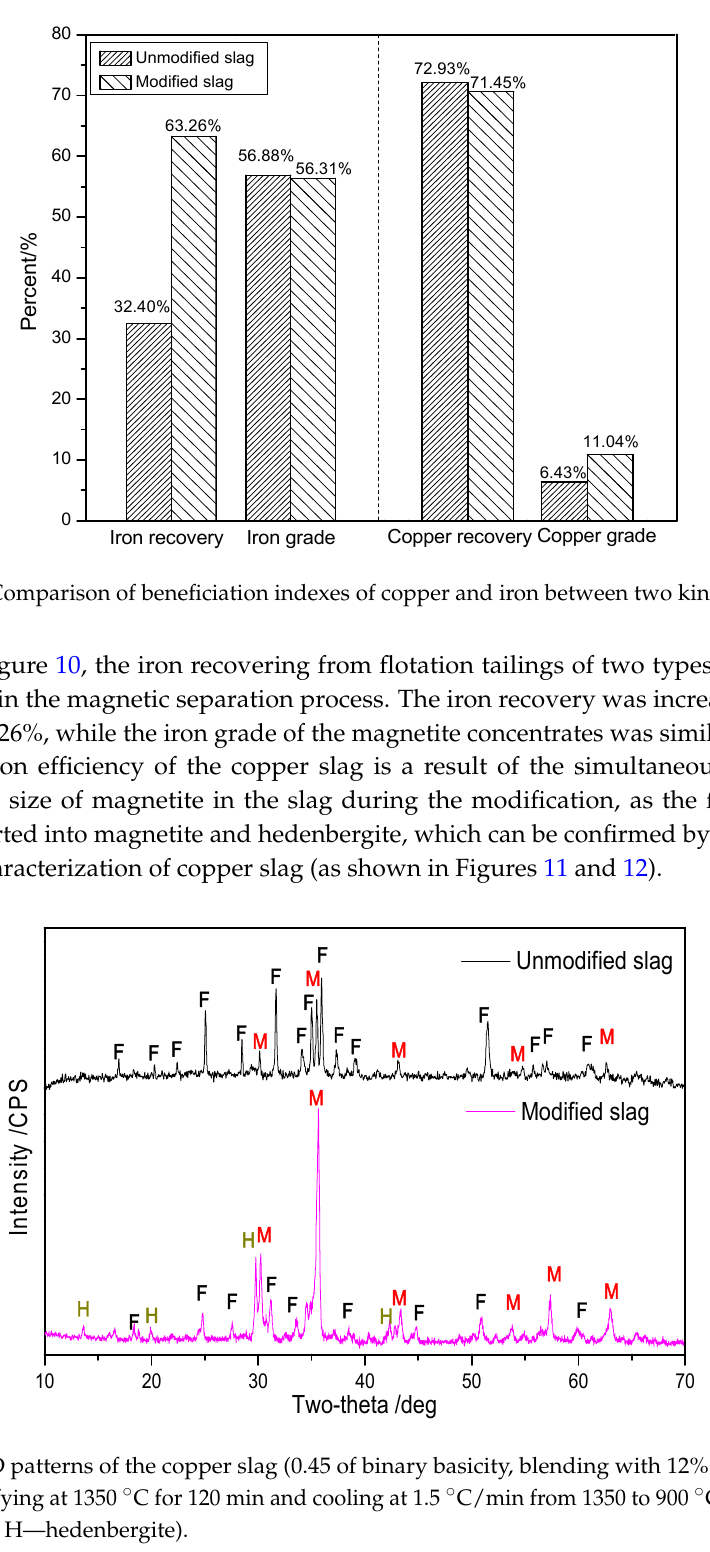
Figure 11. XRD patterns of the copper slag (0.45 of binary basicity, blending with 12% of compound additive, modifying at 1350 °C for 120 min and cooling at 1.5 °C/min from 1350 to 900 °C) (F—fayalite; M—magnetite; H—hedenbergite).